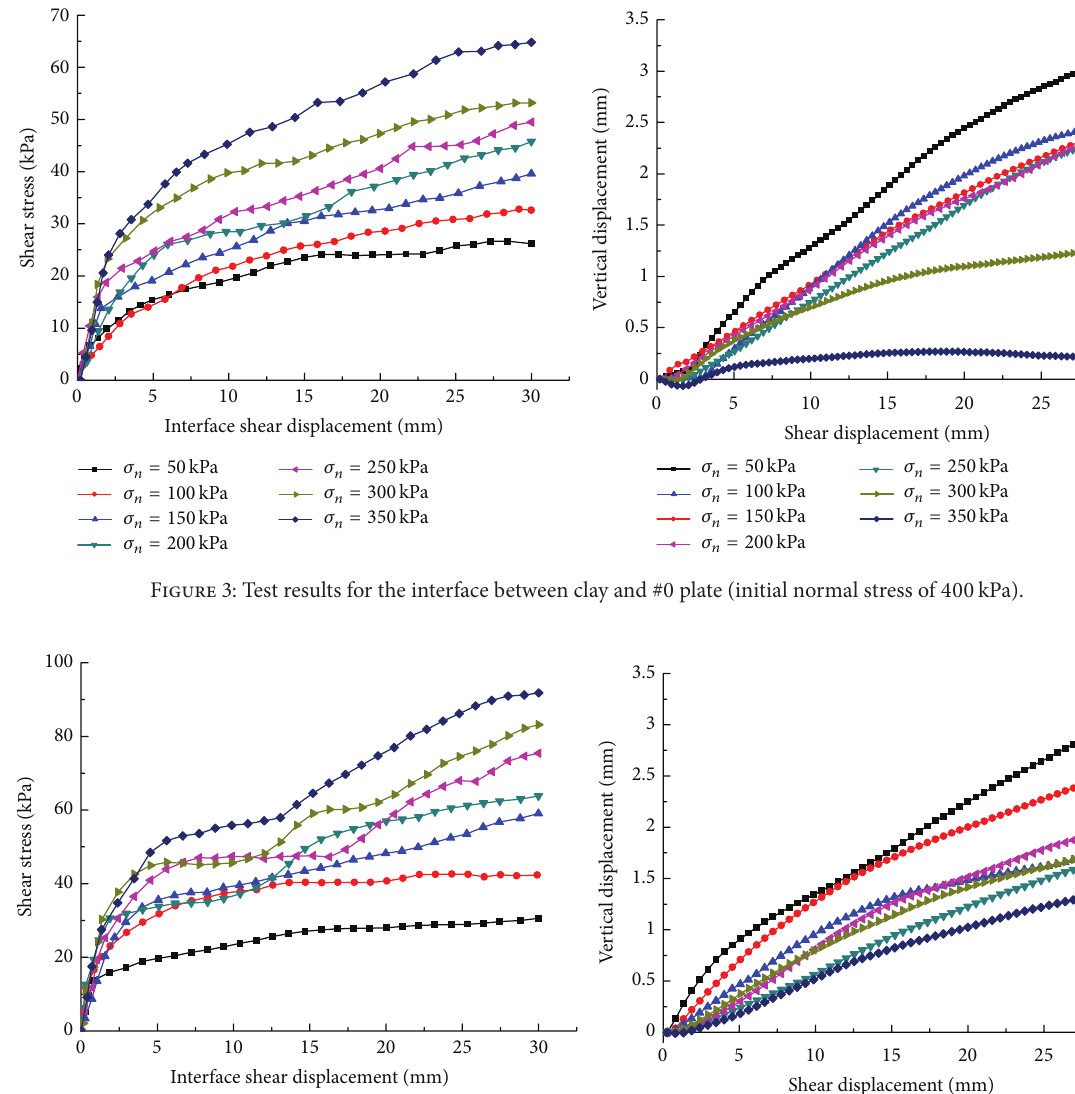
not experiencing normal unloading, the rougher interface exhibits a higher maximum shear stress, as depicted in Figure 10; #2 interface exhibited the highest maximum shear stress under the same stress history, the second highest was for #1 interface, and #0 interface had the lowest